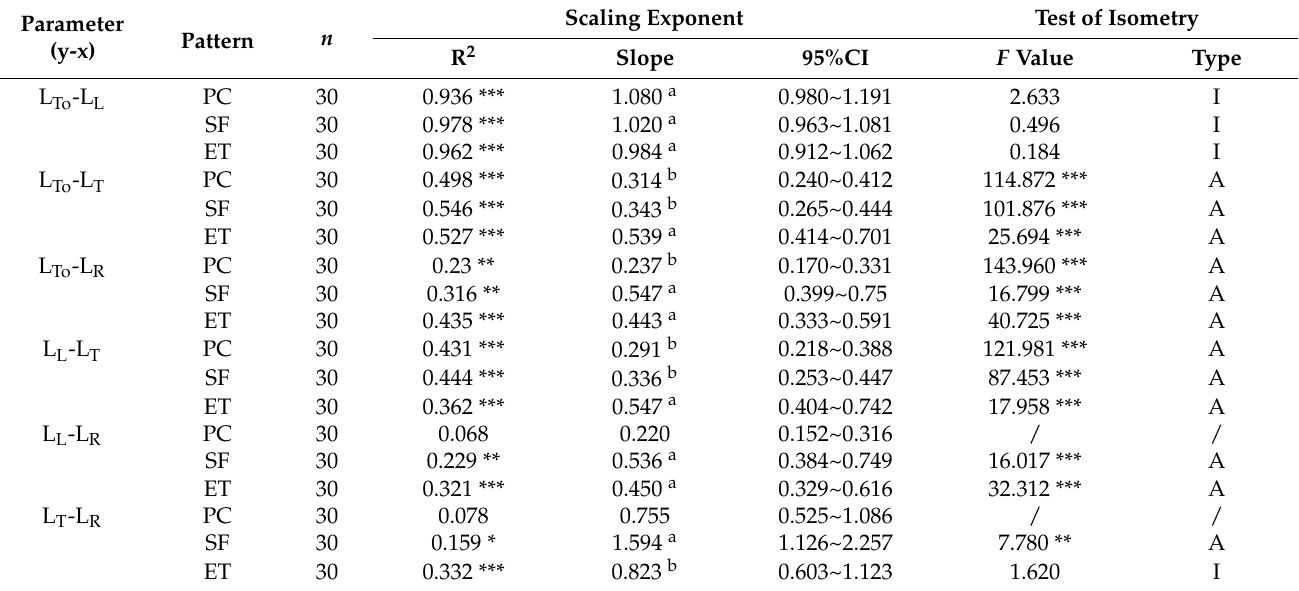
Table 1. Allometric scaling relationships between different litter components in different plantations (L To : total litterfall; L L : leaf litterfall; L T : twig litterfall; L R : reproductive organ